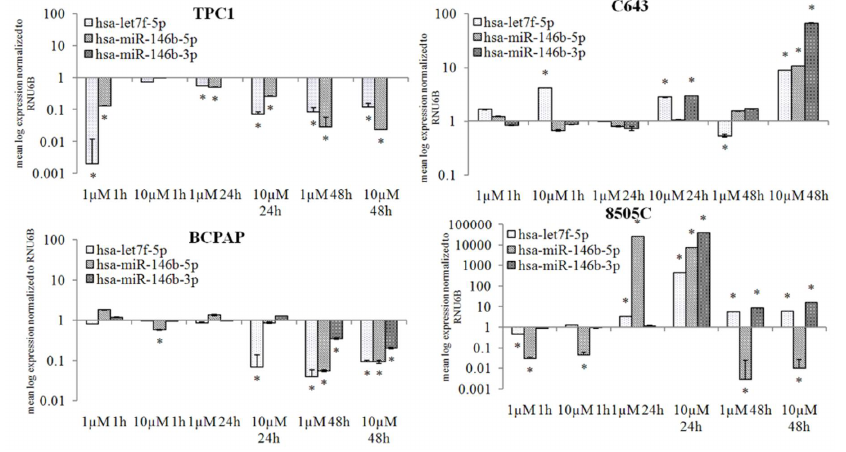
Figure 5. MiRNA expression affected by selumetinib. RT-qPCR of hsa-let7f-5p, hsa-miR-146b-5p and, hsa- miR-146b-5p in TPC1, C643, BCPAP and 8505C cells treated for 48 h with 1 and 10 µM selumetinib. MiRNA transcripts were normalized to RNU6B. Results are expressed relative to the untreated control. Data represent mean ± SEM of experiments performed in triplicates. * p < 0.05 regarded as significant.